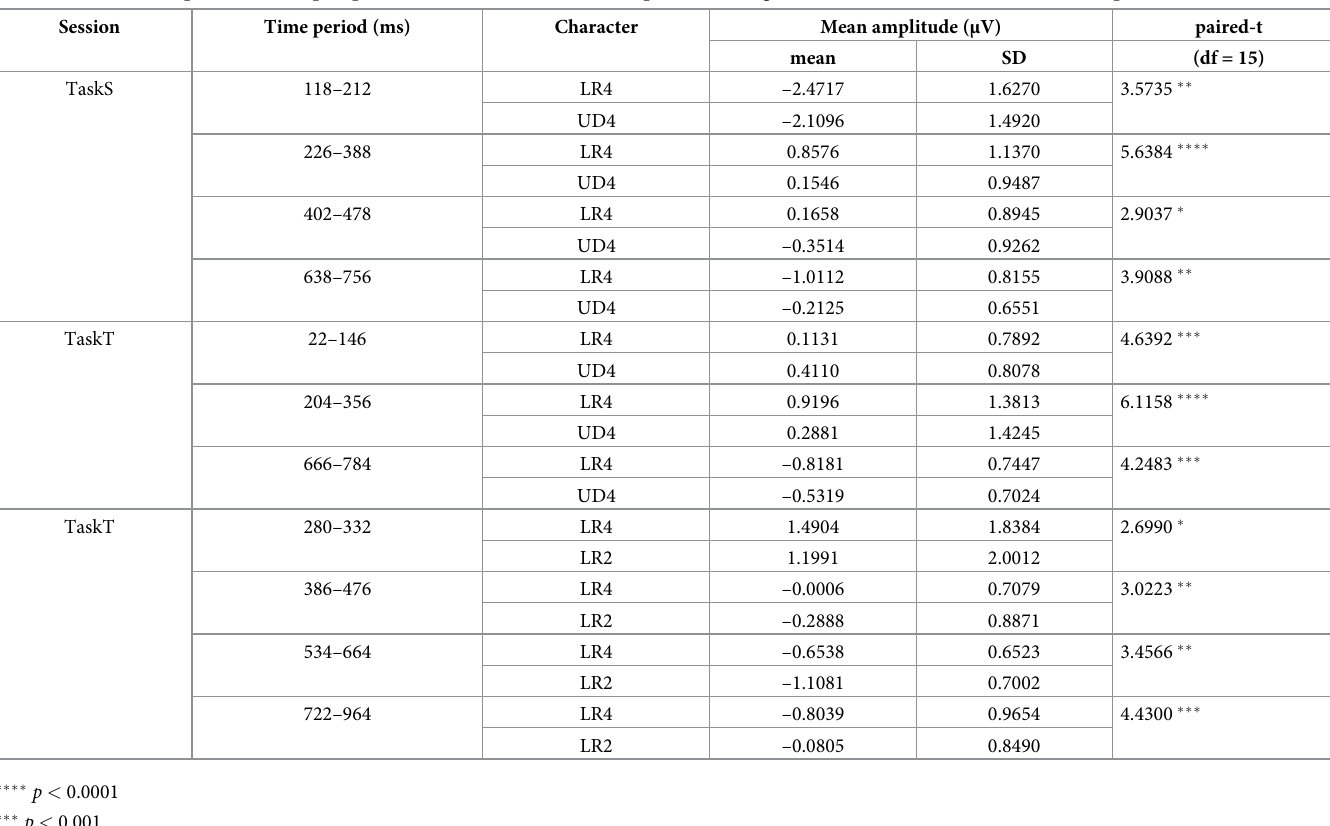
Table 2. Effects of occipital ERPs (scalp responses at PO3/4/7/8 and O1/2 collapsed) reflecting extraction of abstract structural or tonal